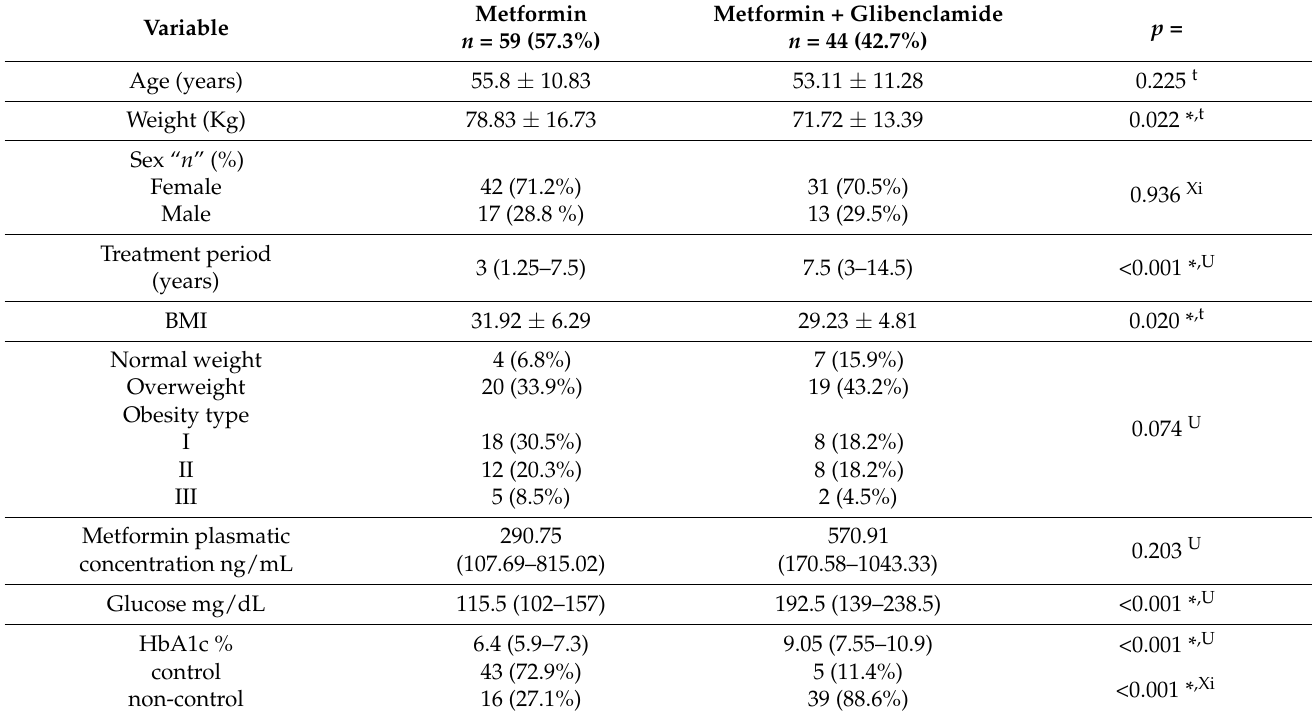
Table 1. Anthropometric traits and clinical biochemistry of DMT2